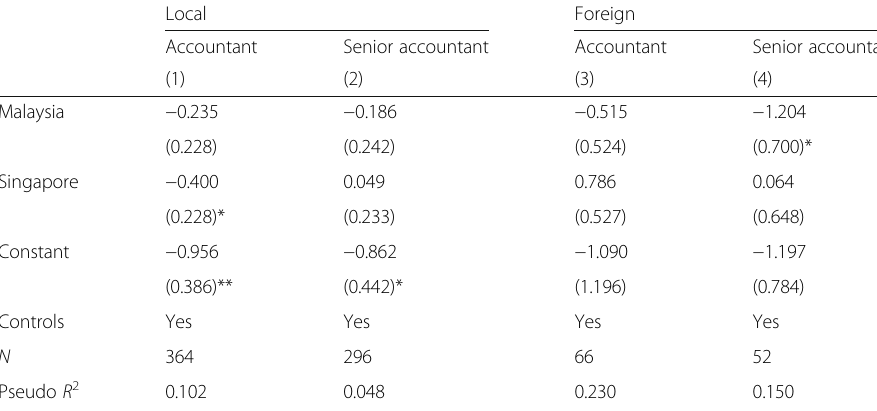
Table 15 Dependent variable: if a resume is the first to receive a callback for an interview